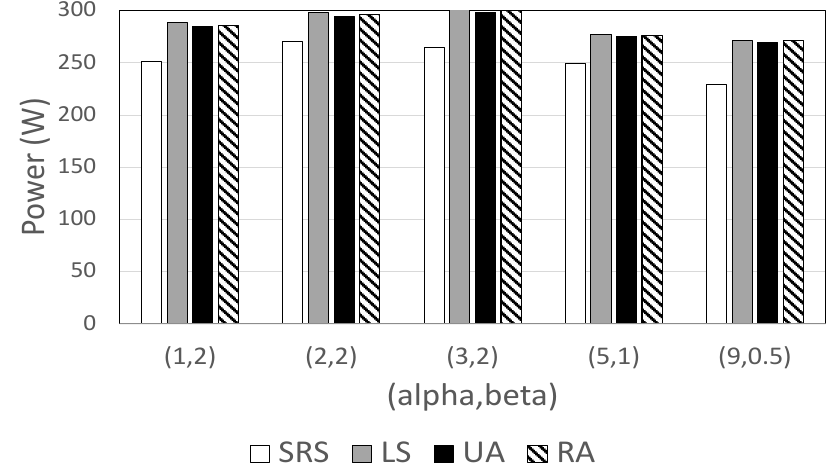
Figure 7. HDD power consumption against α and β parameters of gamma